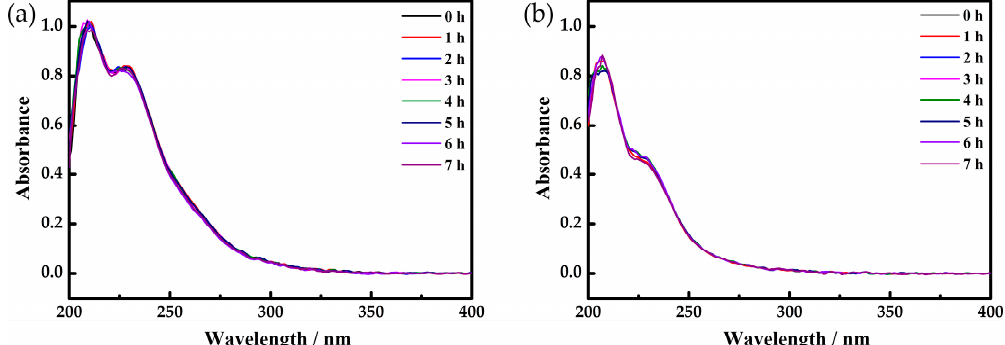
Figure 4. UV spectra of compounds 1 ( a ) and 2 ( b ).